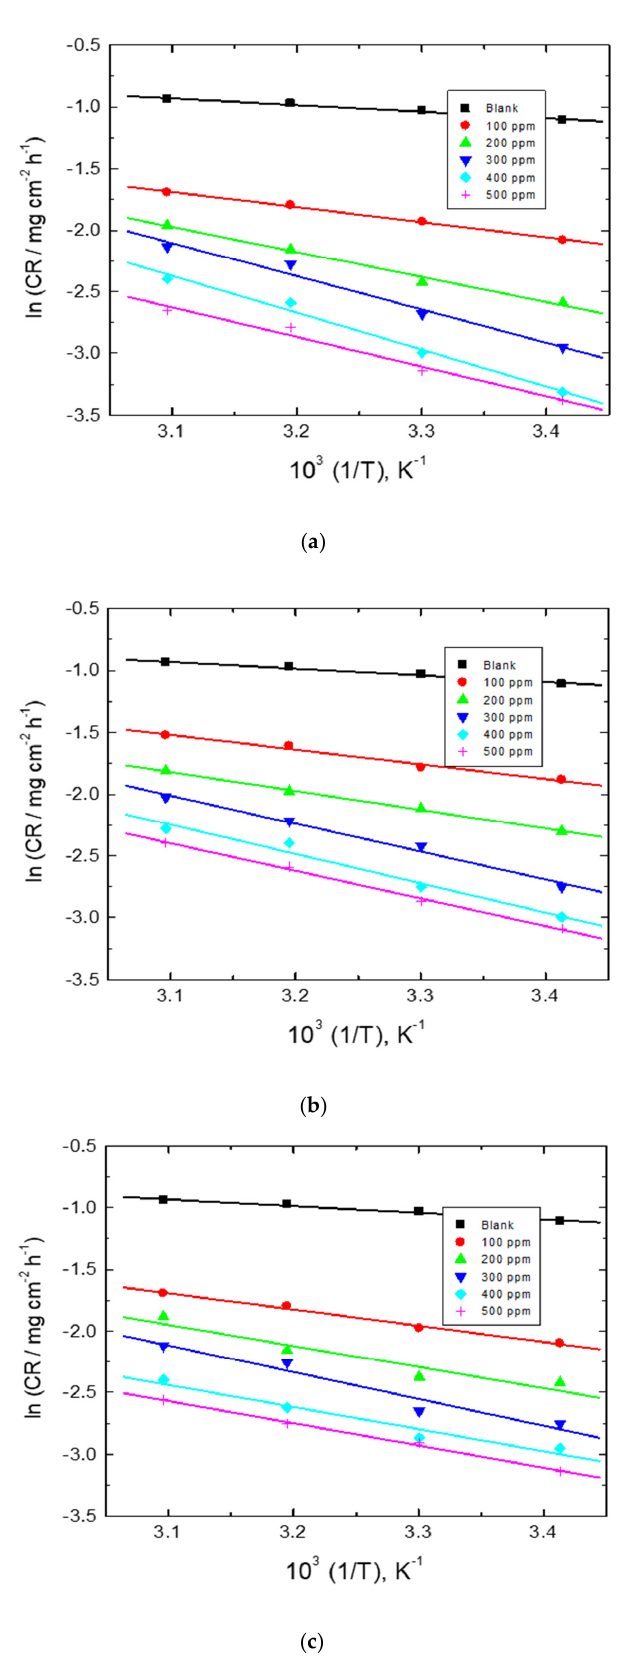
Figure 15. Arrhenius plots for mild-steel corrosion l in 0.5 M HCl solution without and with adding numerous concentrations of the examined carbohydrate polymers: (a) Chi, (b) Pec, and (c) A-Pec.